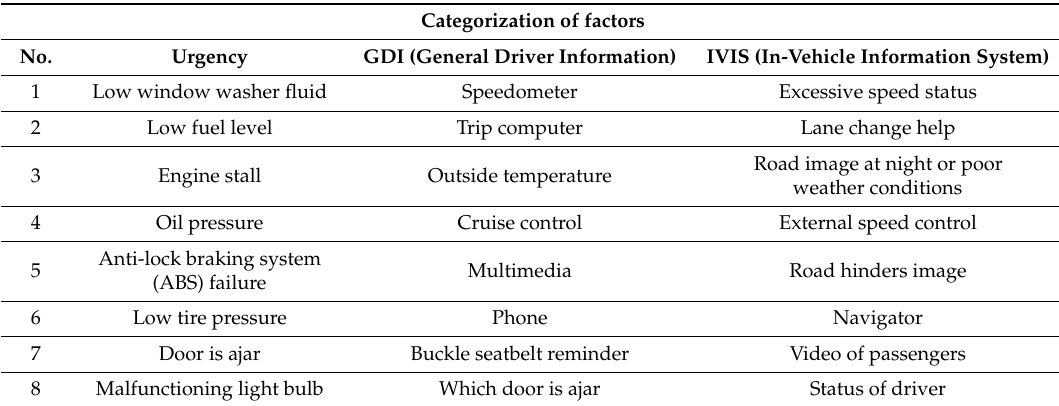
Table 1. Categorization of